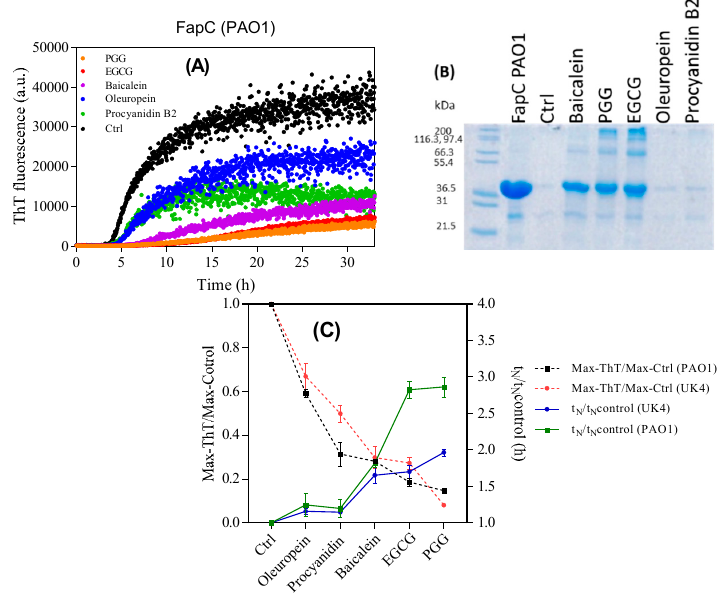
Figure 4. Incubation of FapC from P. aeruginosa with different polyphenols. ( A ) ThT time profile of 30 µM FapC-PAO1 incubated with 100 µM polyphenols with shaking at 37 °C; ( B ) SDS-PAGE analysis of end-point samples from panel A. Epigallocatechin gallate (EGCG), penta- O -galloyl- β - D -glucose (PGG), and Baicalein maintain FapC in the monomeric or oligomeric state and inhibit fibrillation; ( C ) normalized end-point ThT levels and lag times of FapC fibrillation with different polyphenols.